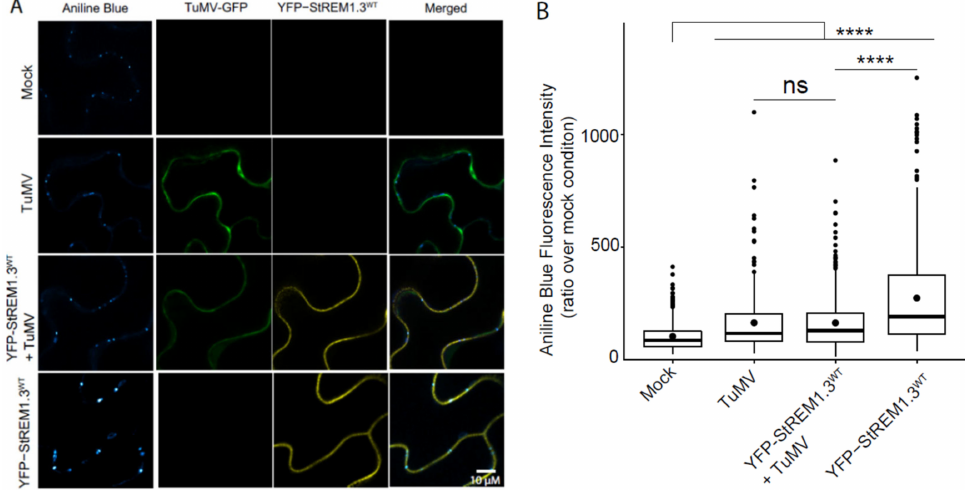
Figure 8. TuMV prevents StREM1.3-induced callose accumulation at plasmodesmata: ( A ) represen- tative confocal images of aniline blue-stained N. benthamiana leaf epidermis cells expressing either YFP–StREM1.3, TuMV–GFP, or both. Colour code of the aniline blue track indicates intensity (the lightest the colour, the more intense). Mock corresponds to the negative control (empty vector agrobacteria); ( B ) quantification of callose accumulation at plasmodesmata was performed by measur- ing aniline blue fluorescence at pit field using ImageJ, as previously described in Perraki et al. (2018). At least 392 PD pi -fields from 3 independent experiments were imaged at 3 days post-inoculation (dpi). Statistical analysis was performed using one-way ANOVA, followed by Student’s t -test in R software (ANOVA, p < 2.2 × 10 − 16 ; **** < 0.001). Scale bar: 10 µ